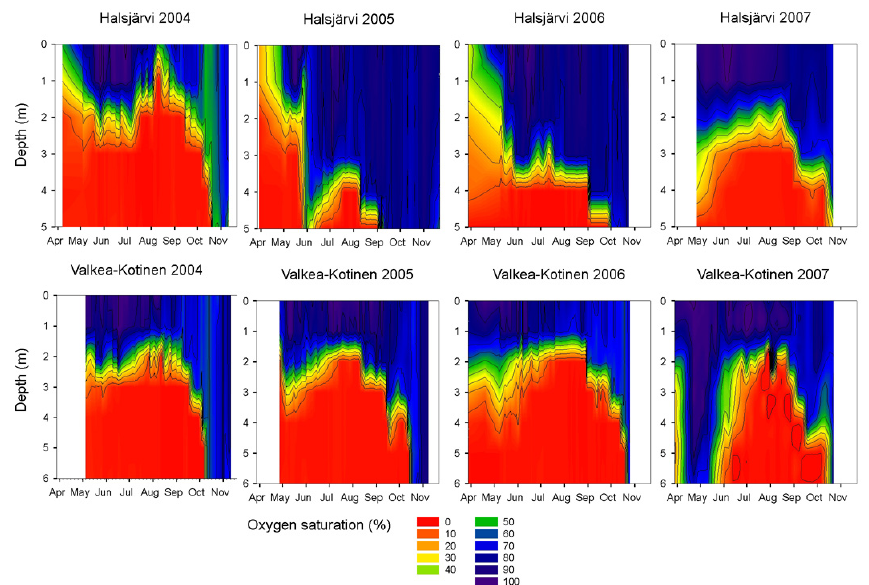
Fig. 7. Interpolated seasonal development of oxygen saturation (%) in lake Halsj¨arvi (upper figures) in the reference years (2004, 2007) and in experimental years (2005, 2006). Lake Valkea-Kotinen (lower figures) as a